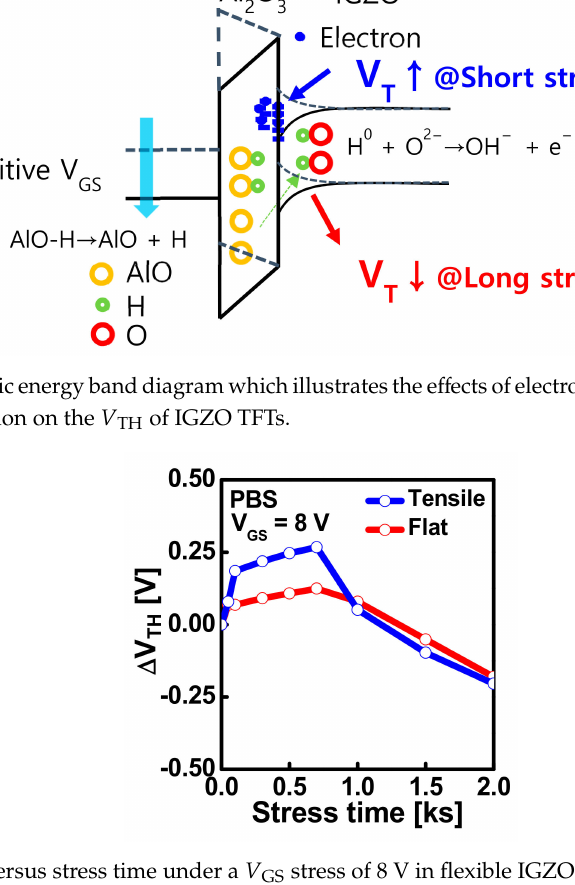
Figure 4. ∆ V TH versus stress time under a V GS stress of 8 V in flexible IGZO TFTs at the flat state and under tensile bending